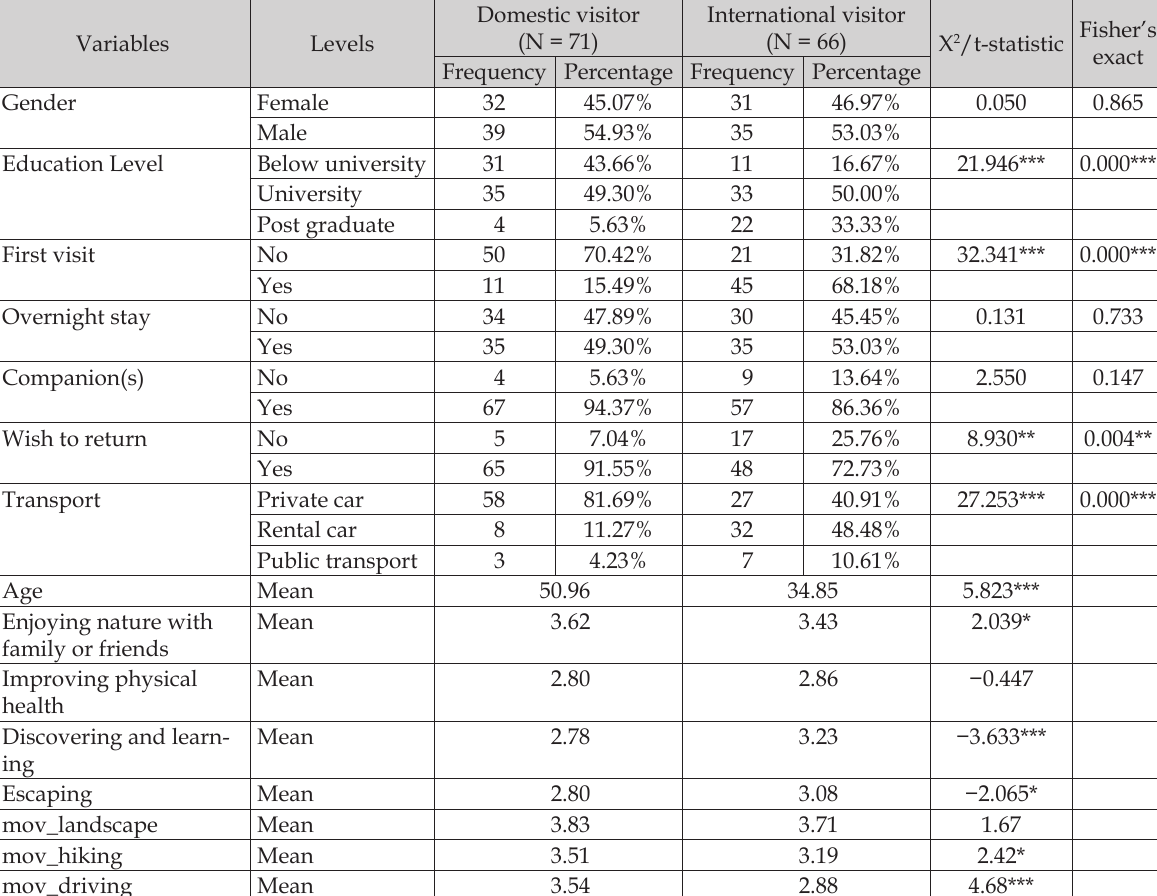
Table 3. Chi-squared, Fisher’s exact, t -tests of distinctions between domestic and international visitors.